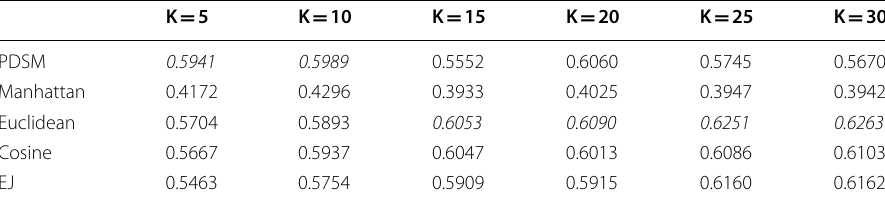
Table 9 K-means clustering AC (WebKB, tf-normal)